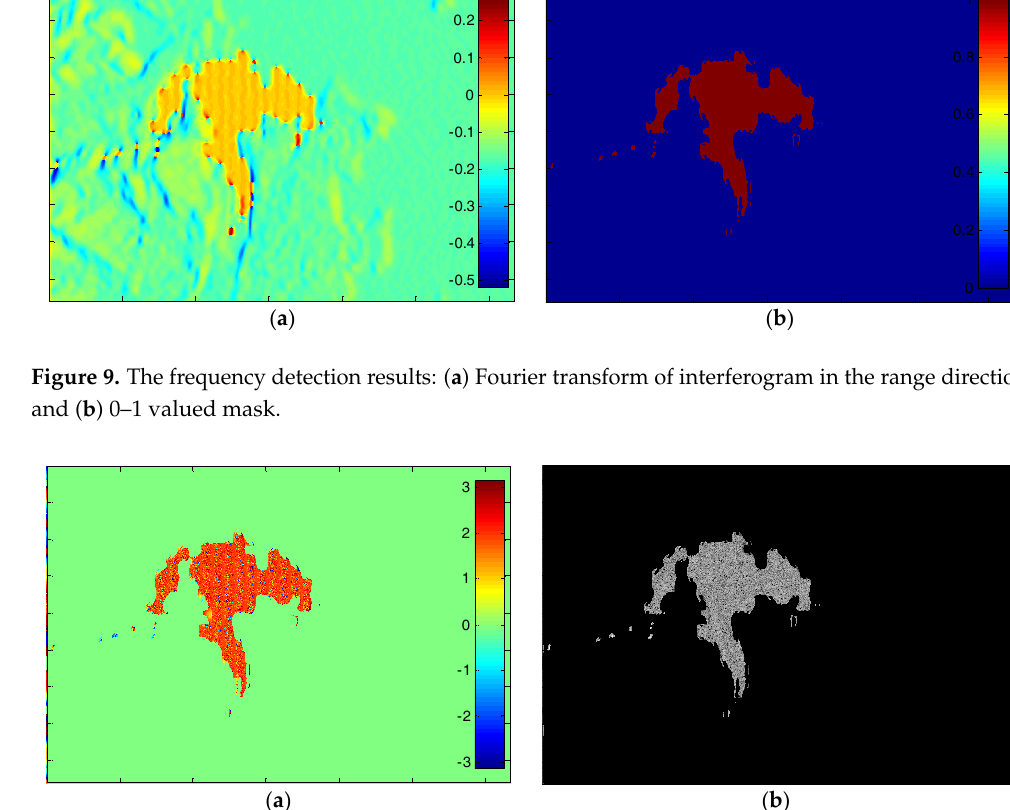
Figure 10. Extraction results: ( a ) false part in the interferogram; and ( b ) false part in the SAR image.